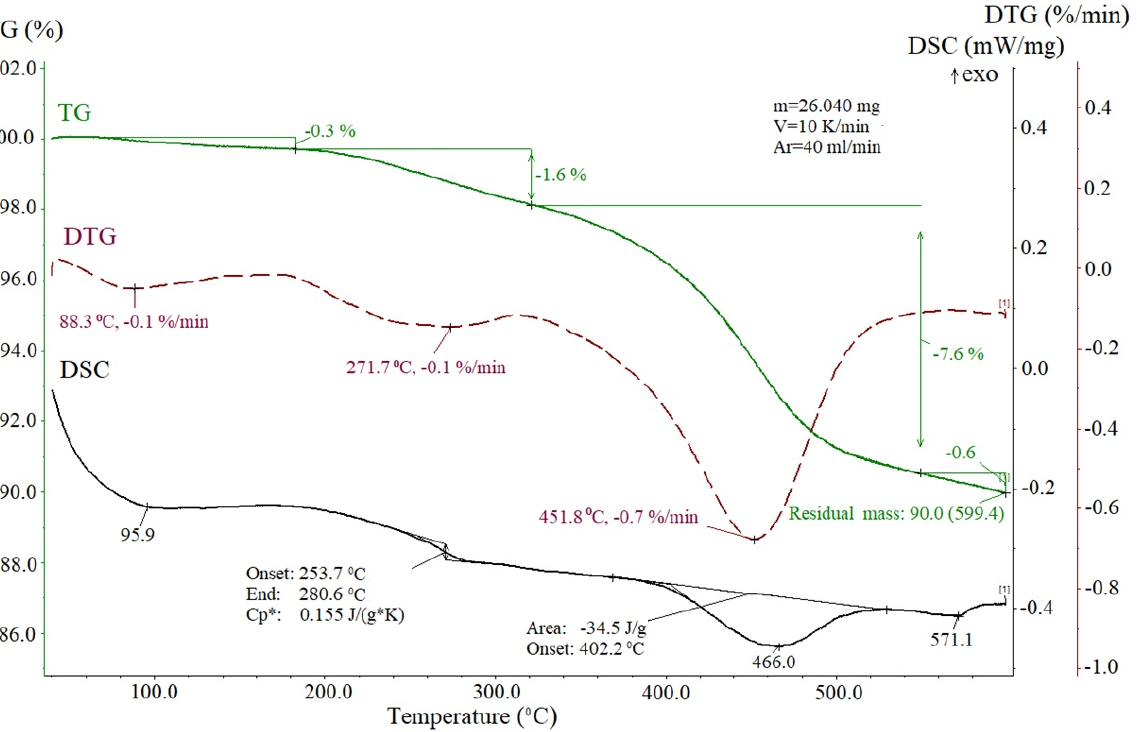
Figure 5. Thermogravimetric (TG) and differential thermogravimetric (DTG) as well differential scanning calorimetric (DSC) profiles of the Fe 3 O 4 @C@C NPs.